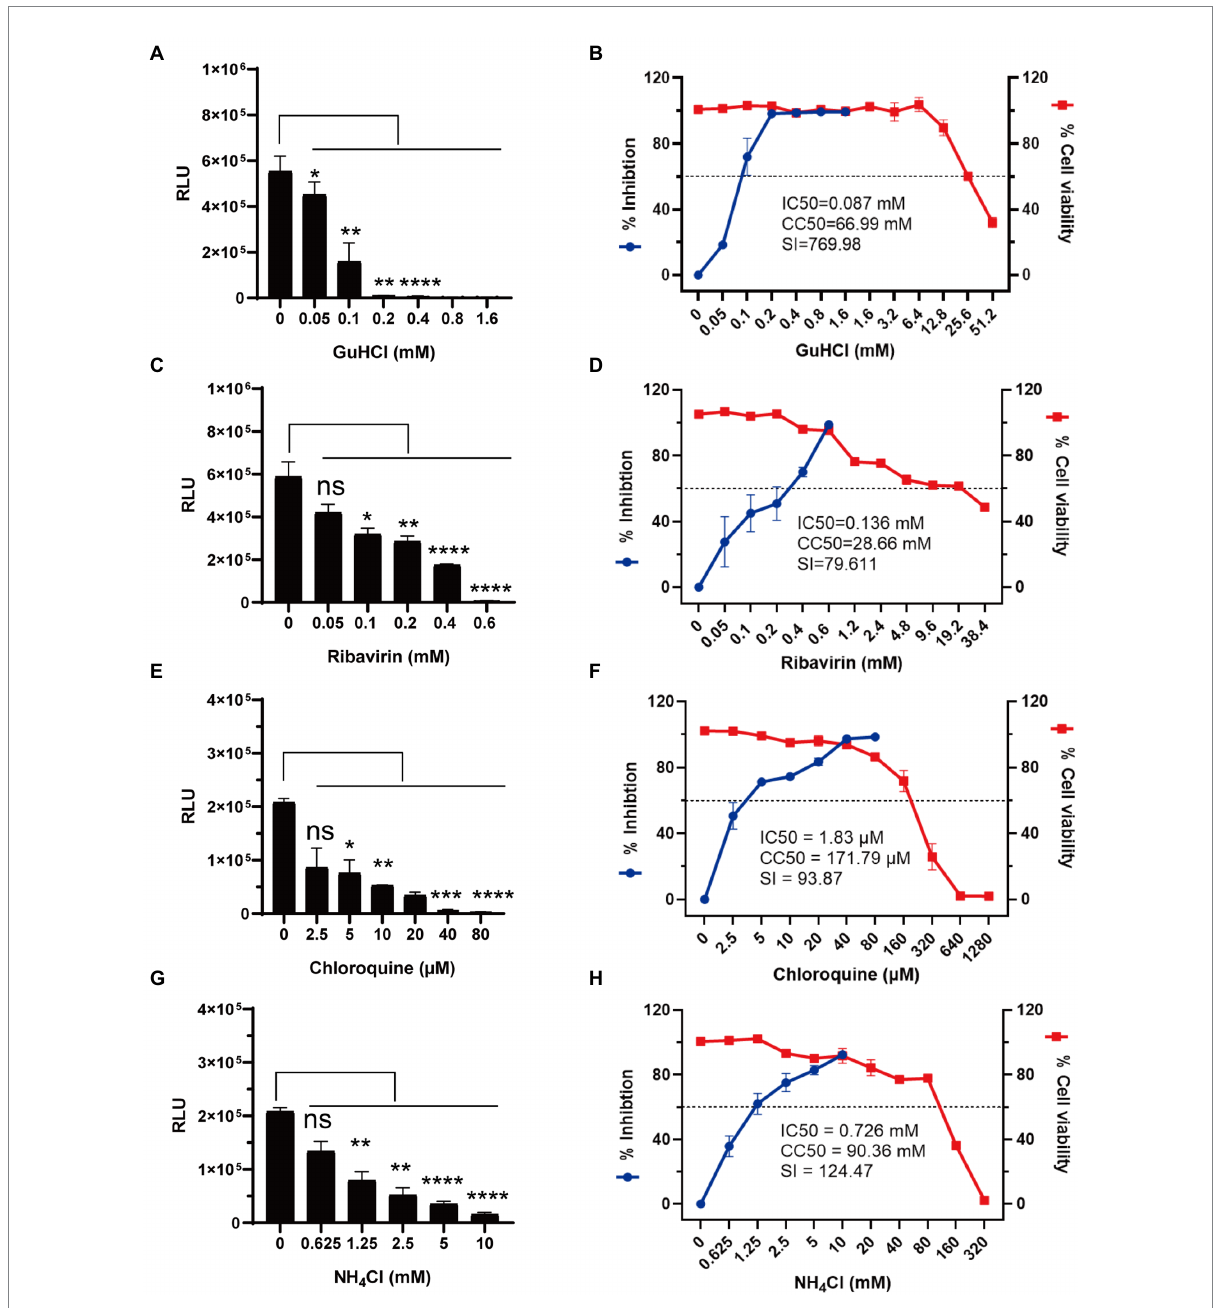
FIGURE 5 Antiviral testing of GuHCl, ribavirin, chloroquine and NH 4 Cl based on rCA16-Nluc. Vero cells were seeded in 96-well plates overnight before rCA16-Nluc (MOI = 0.1) inoculation and antiviral treatment as indicated. RLU was measured 24 h afterwards. Cell viability was measured by the CCK- 8 assay. (A,B) show the luminescence, the calculated inhibition rates and cell viability under different concentrations of GuHCl. (C,D) show the luminescence, the calculated inhibition rates and cell viability under different concentrations of ribavirin. (E,F) show the luminescence, the calculated inhibition rates and cell viability under different concentrations of chloroquine. (G,H) show the luminescence, the calculated inhibition rates and cell viability under different concentrations of NH 4 Cl. Statistical differences were determined using t-test (* P < 0.05; ** P < 0.01; *** P < 0.001; **** P <